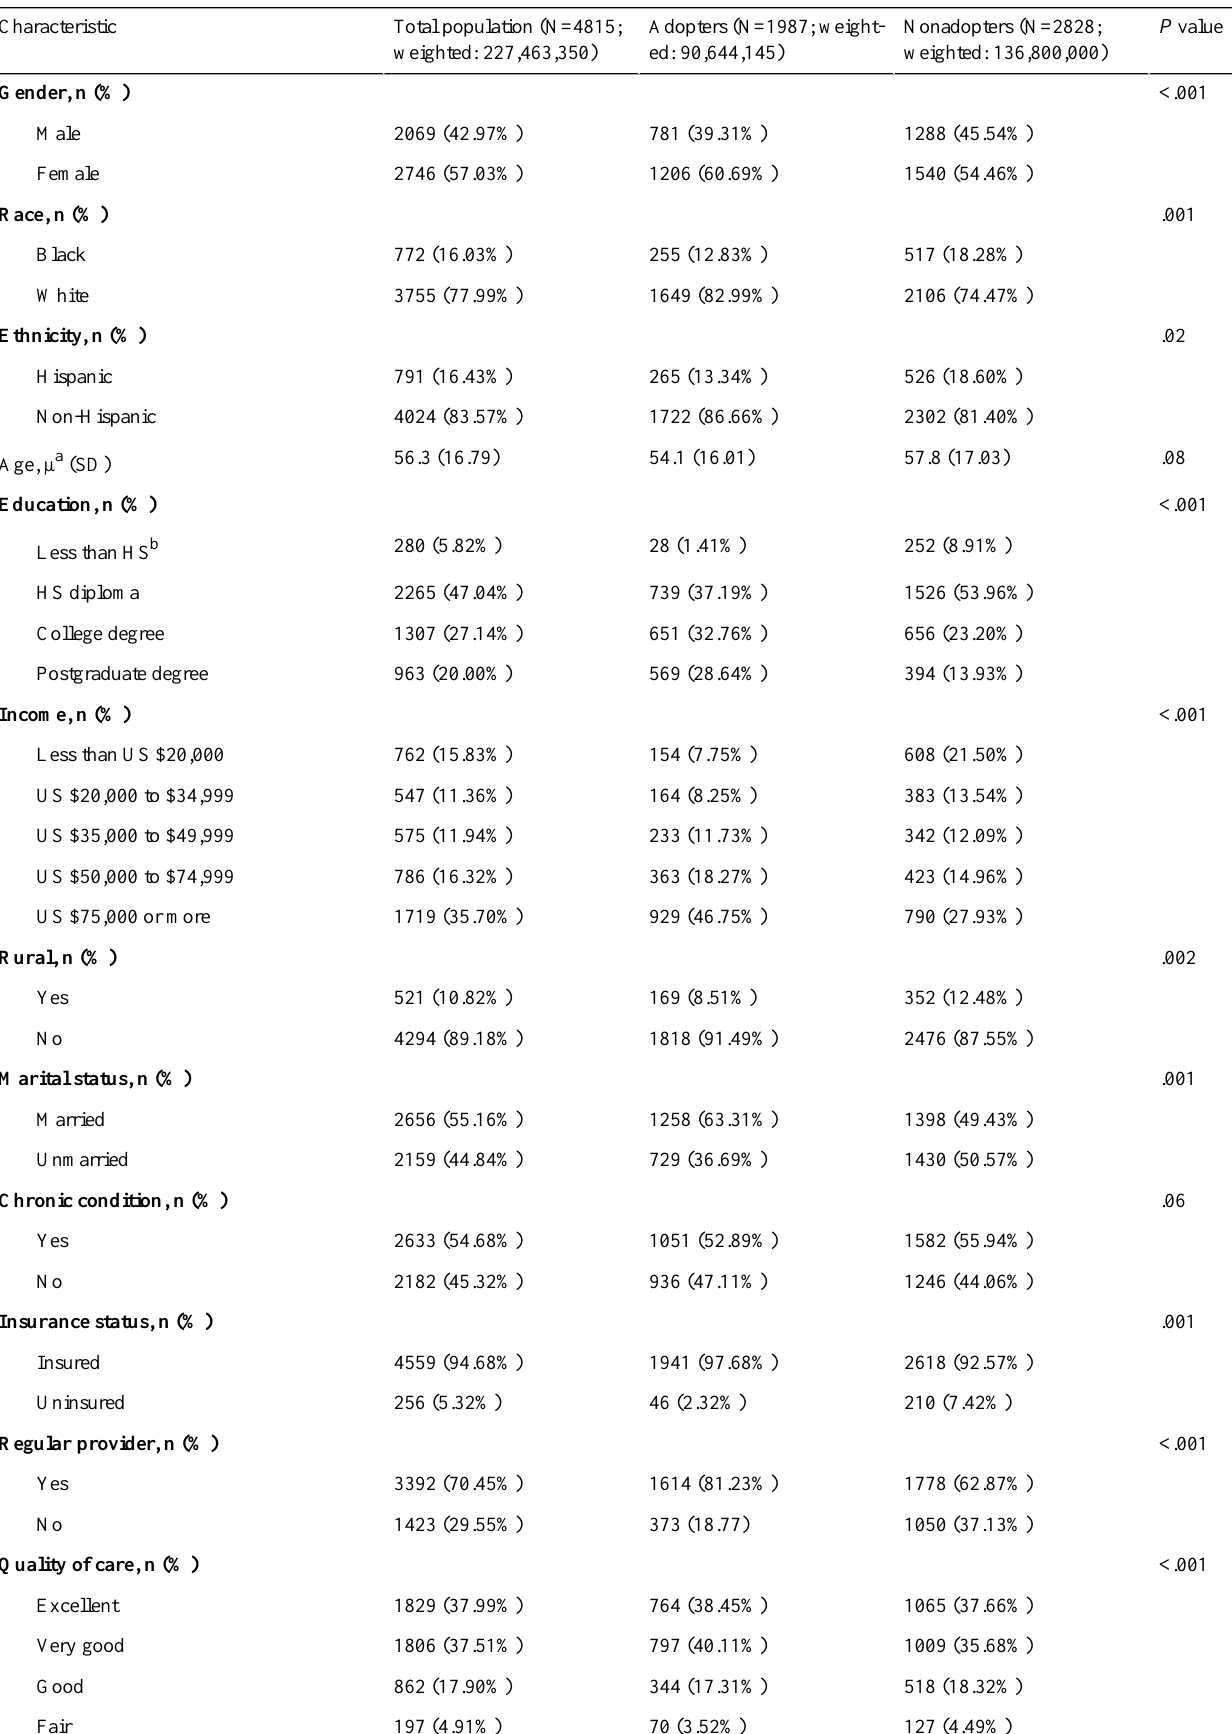
Table 1. Sample characteristics.